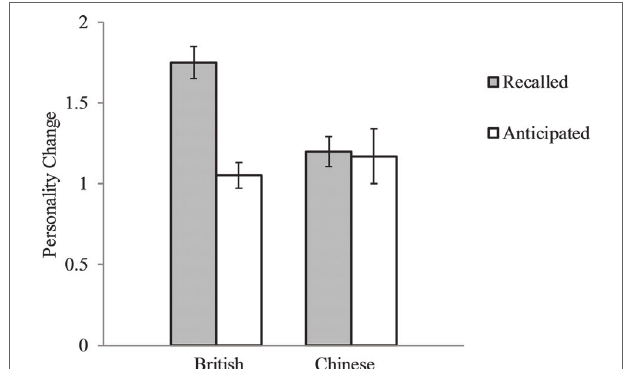
FIGURE 1 | British and Chinese recalled personality changes in the past 10 years and their anticipated personality changes in the future 10 years. Error bars represent standard